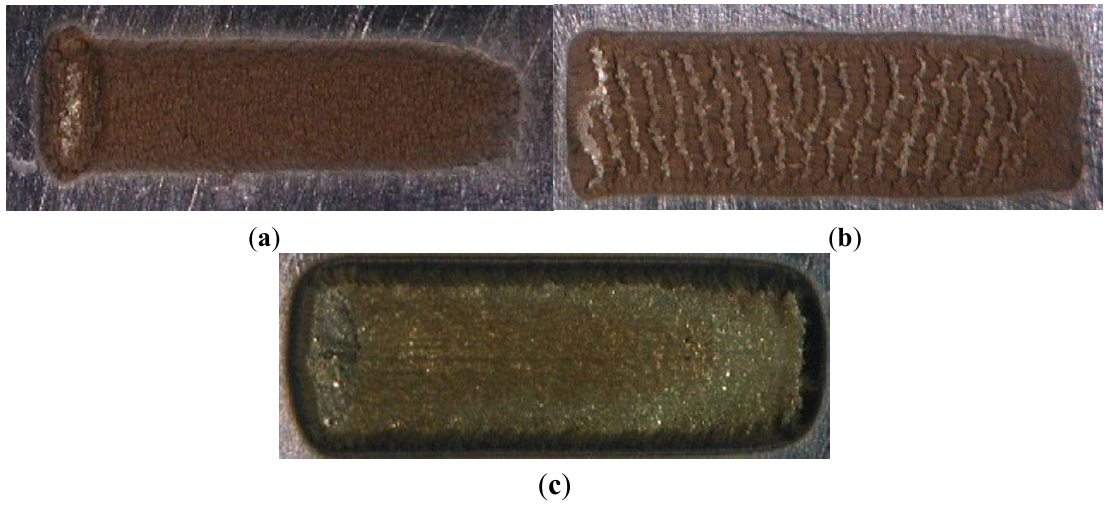
Figure 7. The surface morphology of single beads produced on titanium alloy Ti6Al4V by HPDDL laser gas nitriding at different heat inputs, (Table 2); ( a ) sample No. P20 (laser power 1.5 kW, scanning speed 1.5 m/min, heat input 60 J/mm); ( b ) sample No. P4 (laser power 0.6 kW, scanning speed 0.2 m/min, heat input 180 J/mm); ( c ) sample No. P16. (laser power 1.8 kW, scanning speed 0.4 m/min, heat input 270